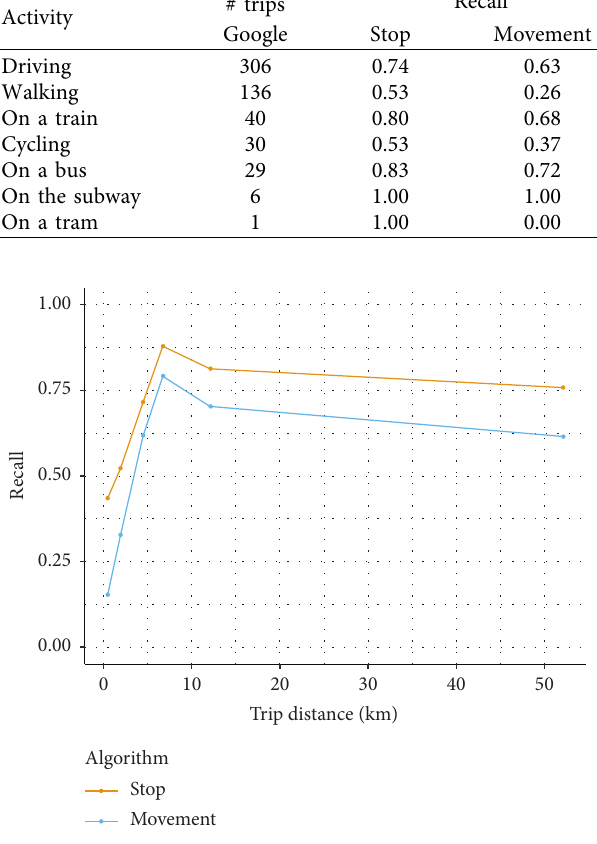
Figure 7: Recall depending on the trip distance. Each datapoint corresponds to 1/6 of the Google trips and shows the share for which of these trips a matching cellular trip was detected by the different trip extraction